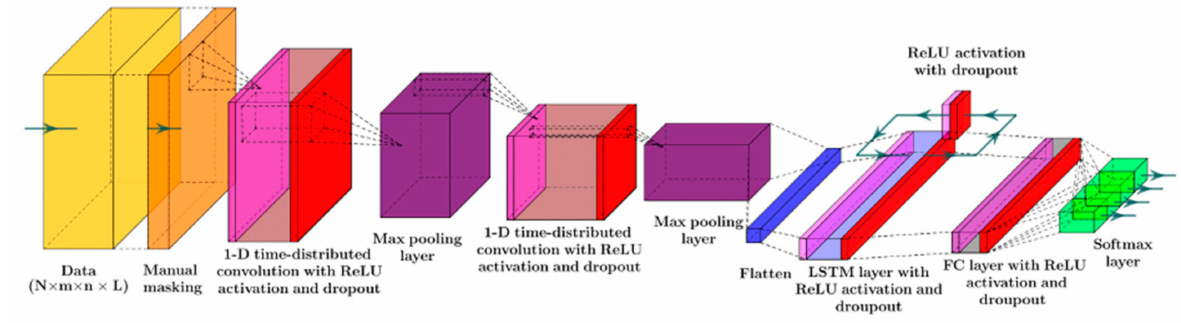
Figure 6. 1-D Convolutional RNN with LSTM layer